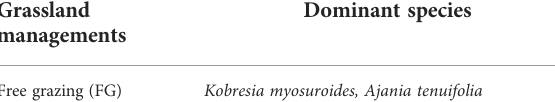
TABLE 1 Dominant species of each sample